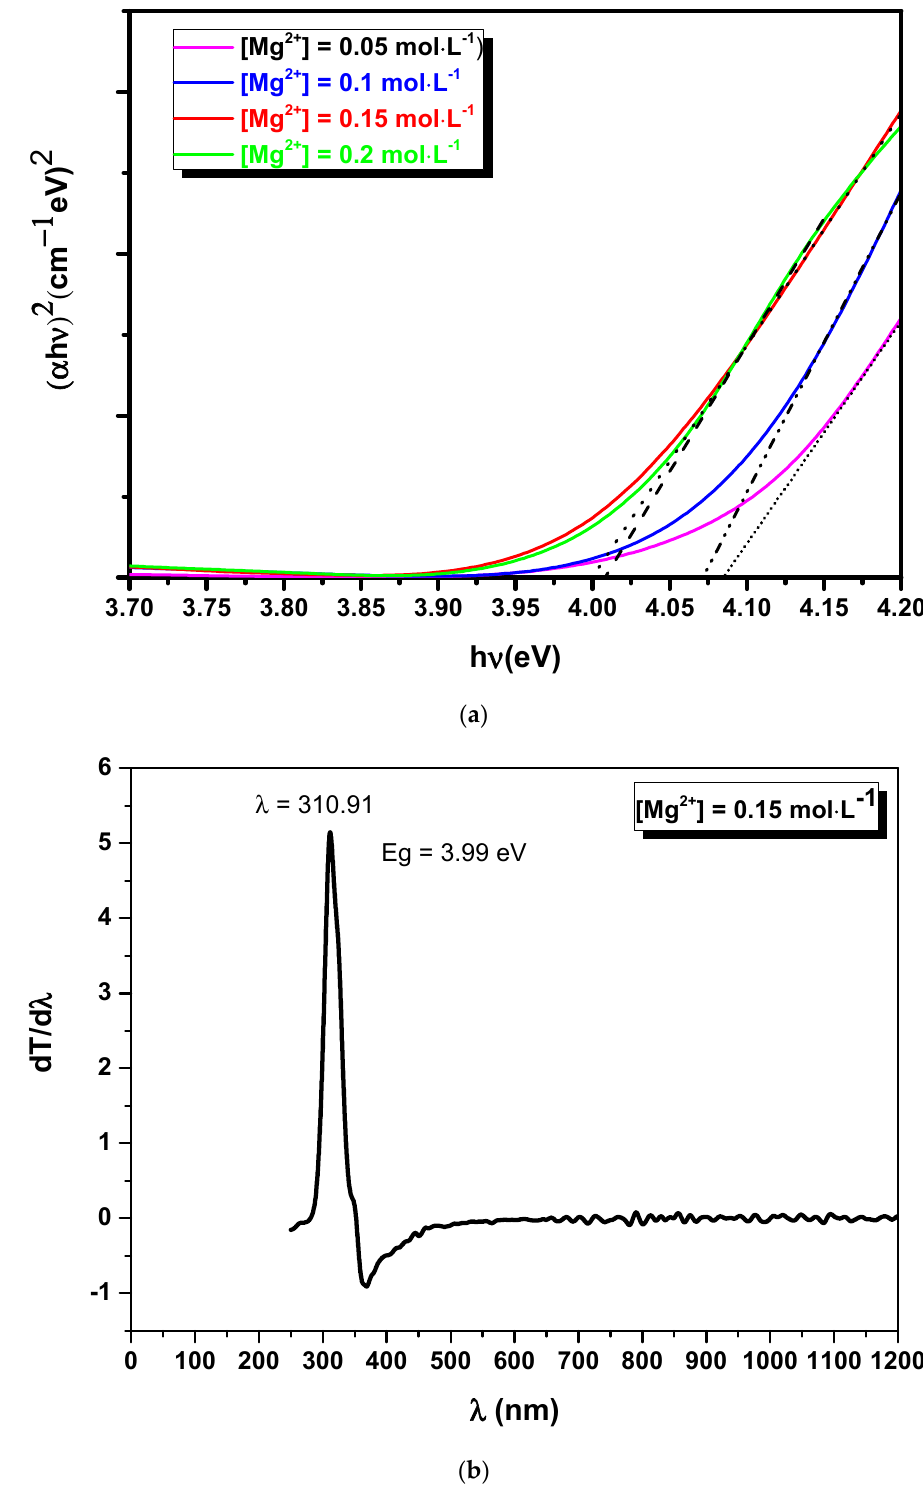
Figure 6. Band gap energy of MgO thin layers deposited by spray for [Mg 2 + ] = 0.05; 0.10; 0.15; and 0.20 mol·L − 1 ( a ) and the value of the band gap energy of MgO for the [Mg 2+ ] = 0.15 mol·L − 1 concentration obtained from the graph of the derivative of T with respect to λ as a function of λ ( b ).